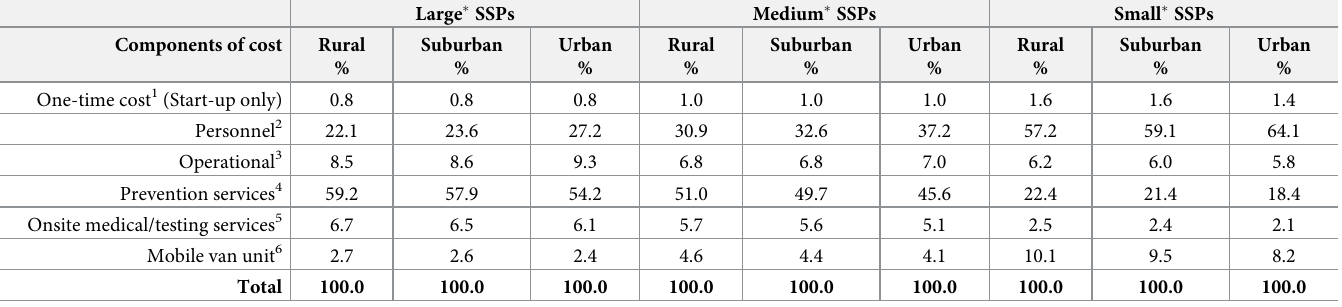
Table 3. Proportional contribution (percentages) of each cost category to the overall total cost of a comprehensive syringe service program (SSP) by size and geo- graphic location, United